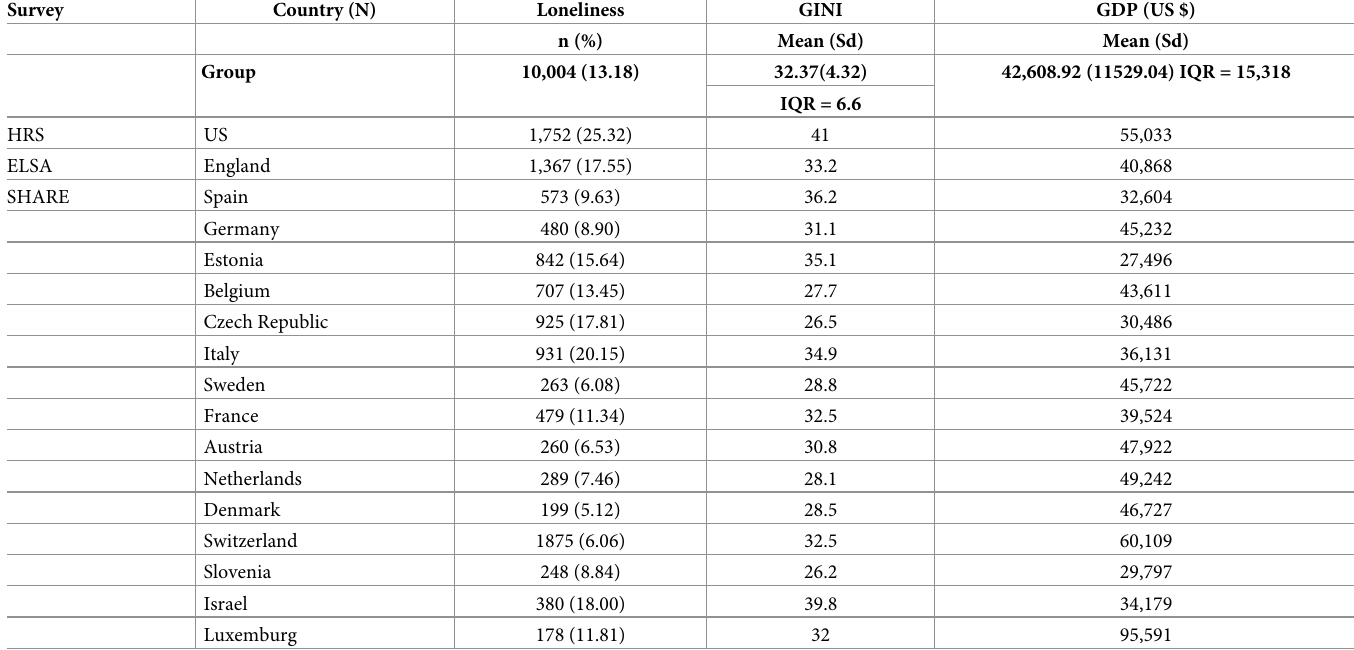
Table 2. Country-level descriptive statistics (n =